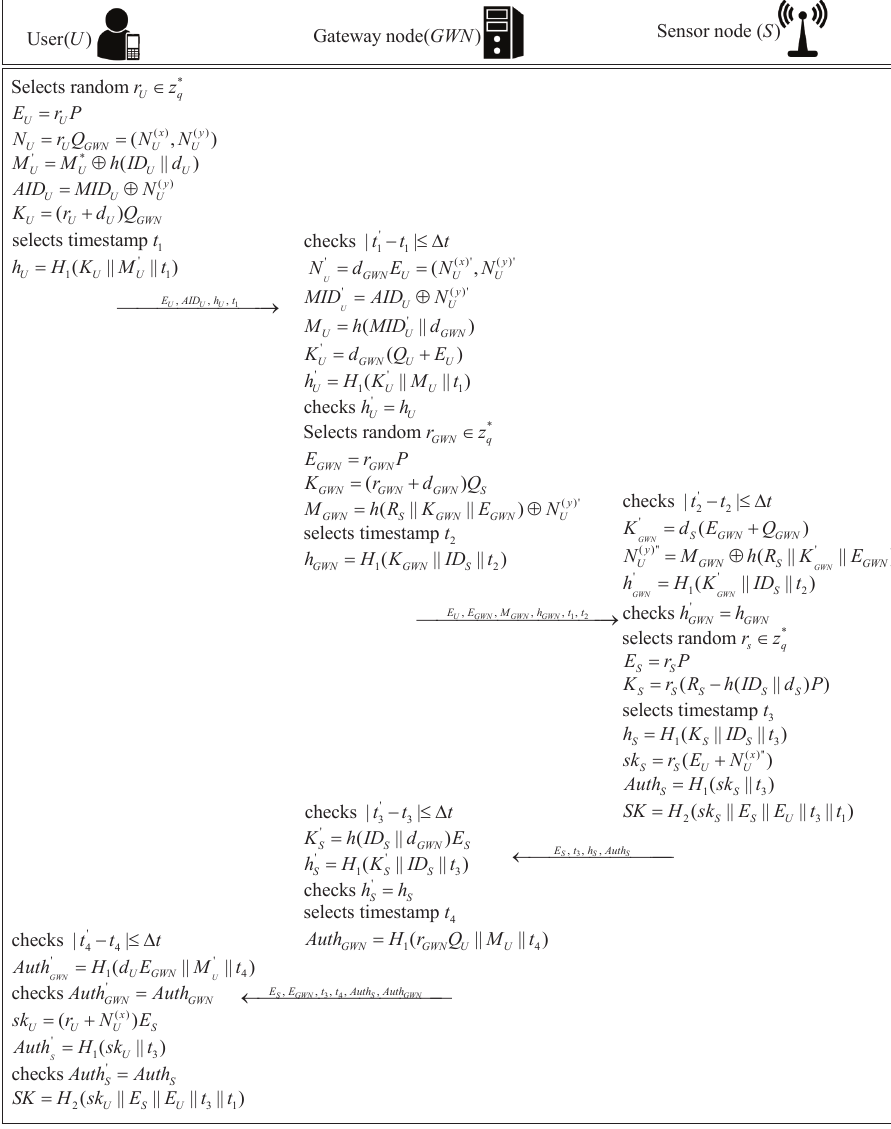
Figure 2. Authentication and key establishing phase of the proposed